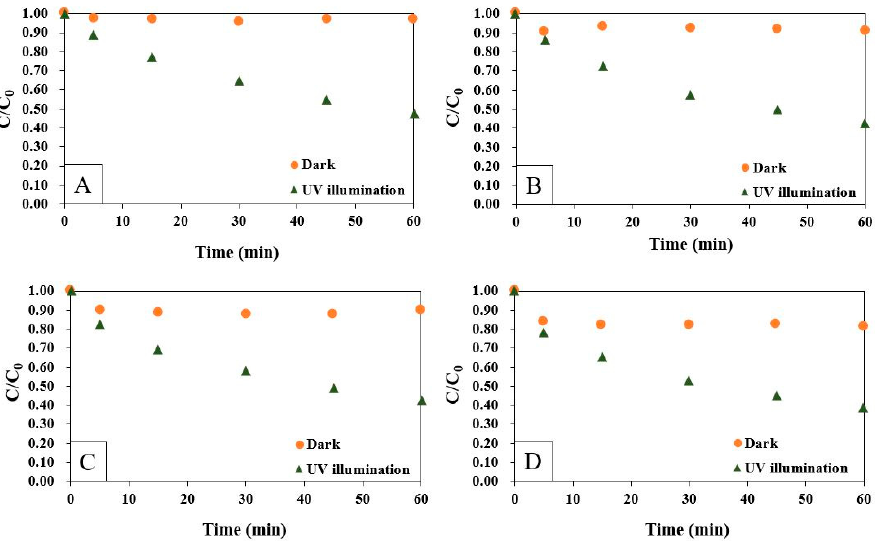
Figure 14. Changes of UV absorption by total dissolved organic compounds during UV/TiO 2 photocatalysis at different TiO 2 loadings: ( A ) 0.1 g/L, ( B ) 0.3 g/L, ( C ) 0.5 g/L, and ( D ) 1.0 g/L.